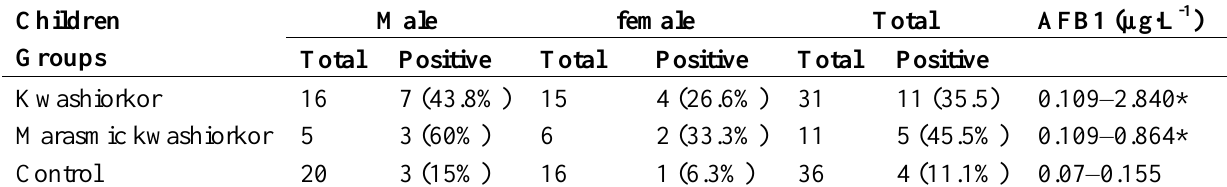
Table 4. Aflatoxin B content in urines of malnourished 1